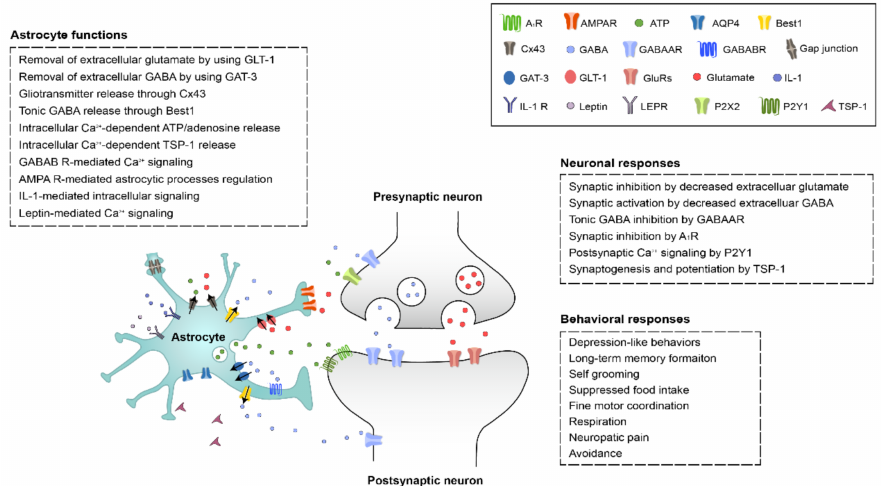
Figure 1. The molecular mechanism underlying astrocytic regulation of neural activity in brain regions. The detailed explanations and references can be found from the text. AA, arachidonic acid; AgRP, agouti-related peptide; AMPAR, α -amino-3-hydroxy-5-methyl-4-isoxazolepropionic acid-type glutamate receptors; AQP4, aquaporin 4; ATP, adenosine triphosphate; Best1, bestrophin 1; Cx43, connexin 43; DAO, diamine oxidase; EET, epoxyeicosatrienoic acid; GABA, γ - aminobutyric acid; GAT-3, GABA transporter type 3; GLT-1, glutamate transporter 1; IL-1, interleukin-1; LEPR, leptin receptor; MAOB, monoamine oxidase B; MSN, medium spiny neuron; PLC, phospholipase C; TC neuron, thalamocortical neuron; TSP-1, thrombospondin-1; VB, ventrobasal nucleus.